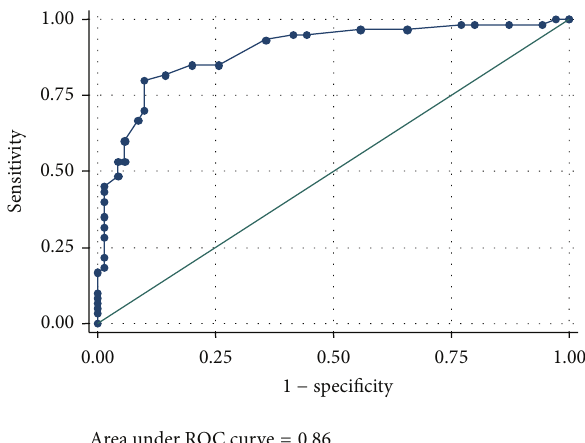
Figure 1: ROC curve for the variable total score for LARS. LARS punctuation versus